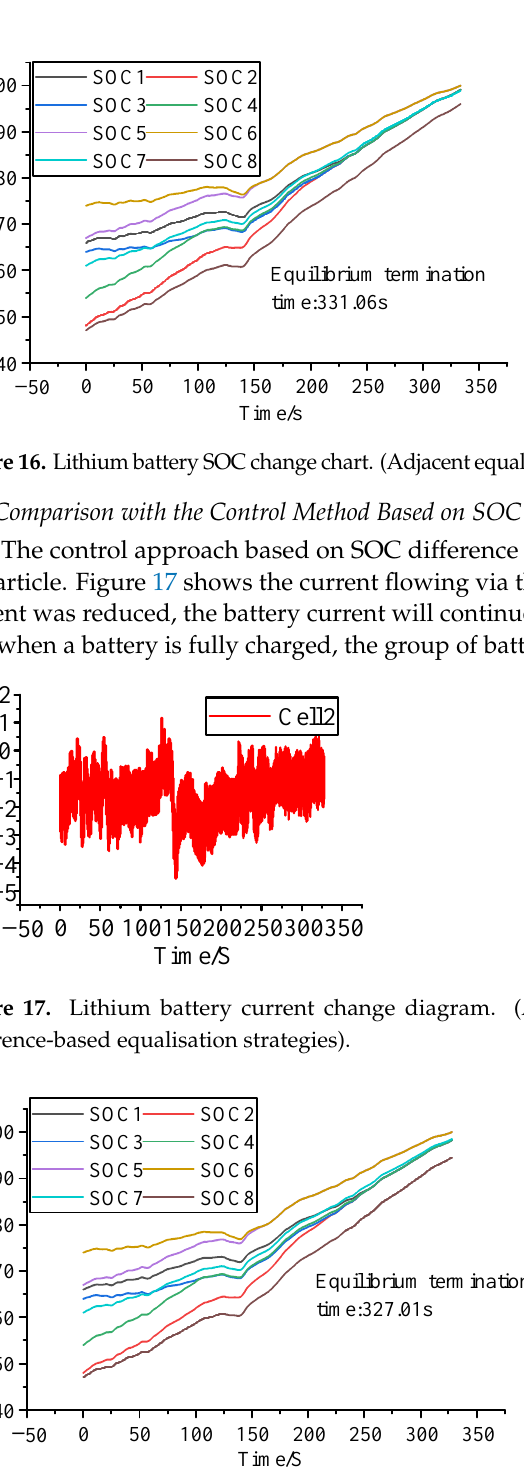
Figure 15. Lithium battery current change diagram. (Adjacent equalisation circuits and fuzzy con- trol strategies)